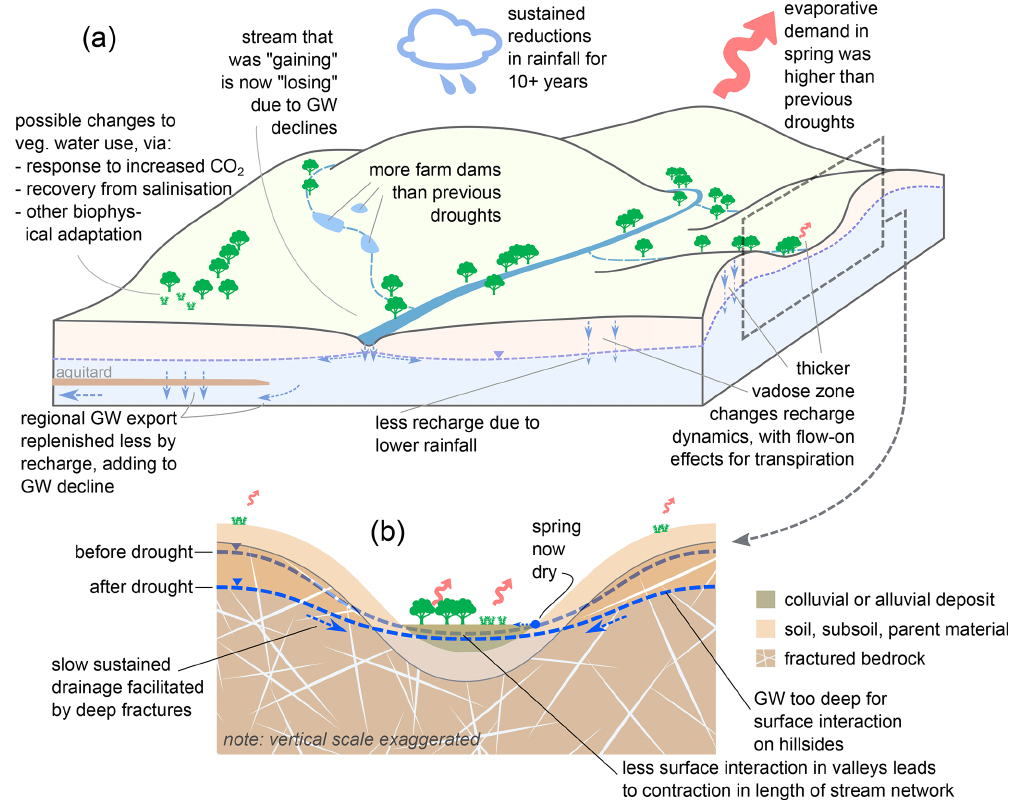
Figure 9. Visual synthesis of selected process explanations explaining why the Millennium Drought had less streamflow than expected, relative to prior droughts (post-1950; these droughts were too short for significant groundwater decline). The situation depicted describes a typical catchment in central or western